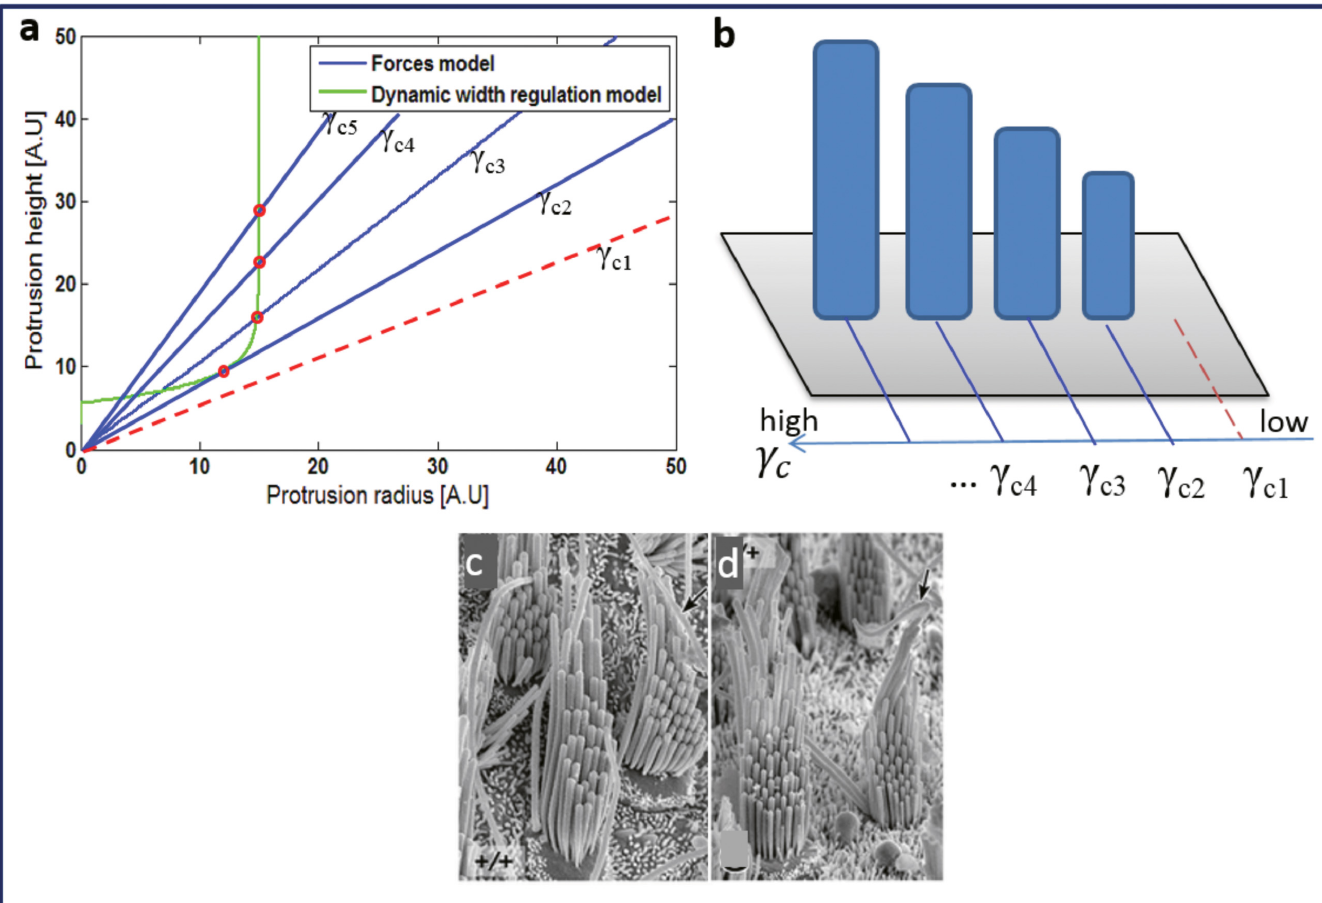
Fig 2. (a) Calculated heights and radii using the theoretical model, with the steady-state solutions indicated by the red circles. Here we take a linear spatial gradient in γ c , and a constant polymerization rate. We get a staircase structure of constant differences in stereocilia heights, but fixed radii (except for the shortest row that are slightly thinner). This result from the model is illustrated in (b). In (c), (d) we compare to the mammalian vestibular stereocilia bundles [26] (Sekerková G et al. (2011) Roles of the espin actin-bundling proteins in the morphogenesis and stabilization of hair cell stereocilia revealed in CBA/CaJ congenic jerker mice. PLoS Genet, 7(3), e1002032-e1002032). The main part of the vestibular bundle has the properties shown in (a,b): stereocilia of equal width (except for thinner first and shortest row), and height increases at a constant gradient between the rows (except for the tallest